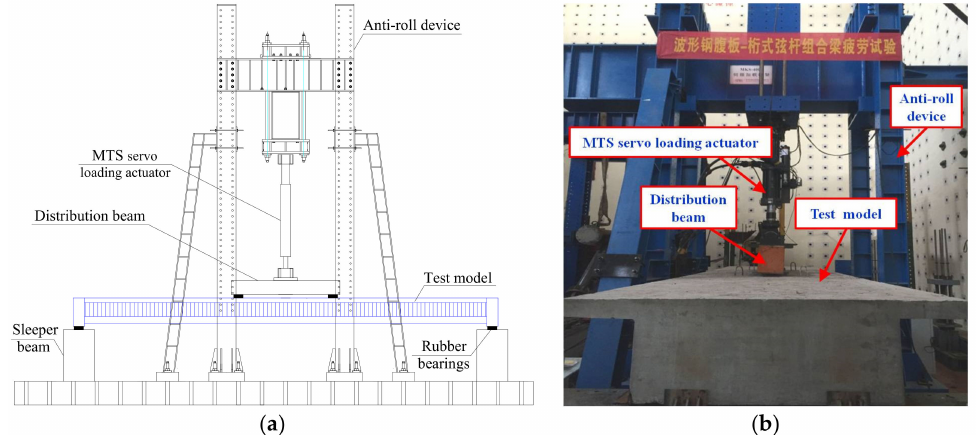
Figure 6. Loading rig: ( a ) schematic diagram; and ( b ) photo of loading rig.